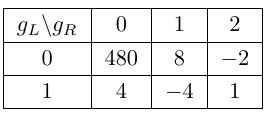
for the homology class β = ( d β